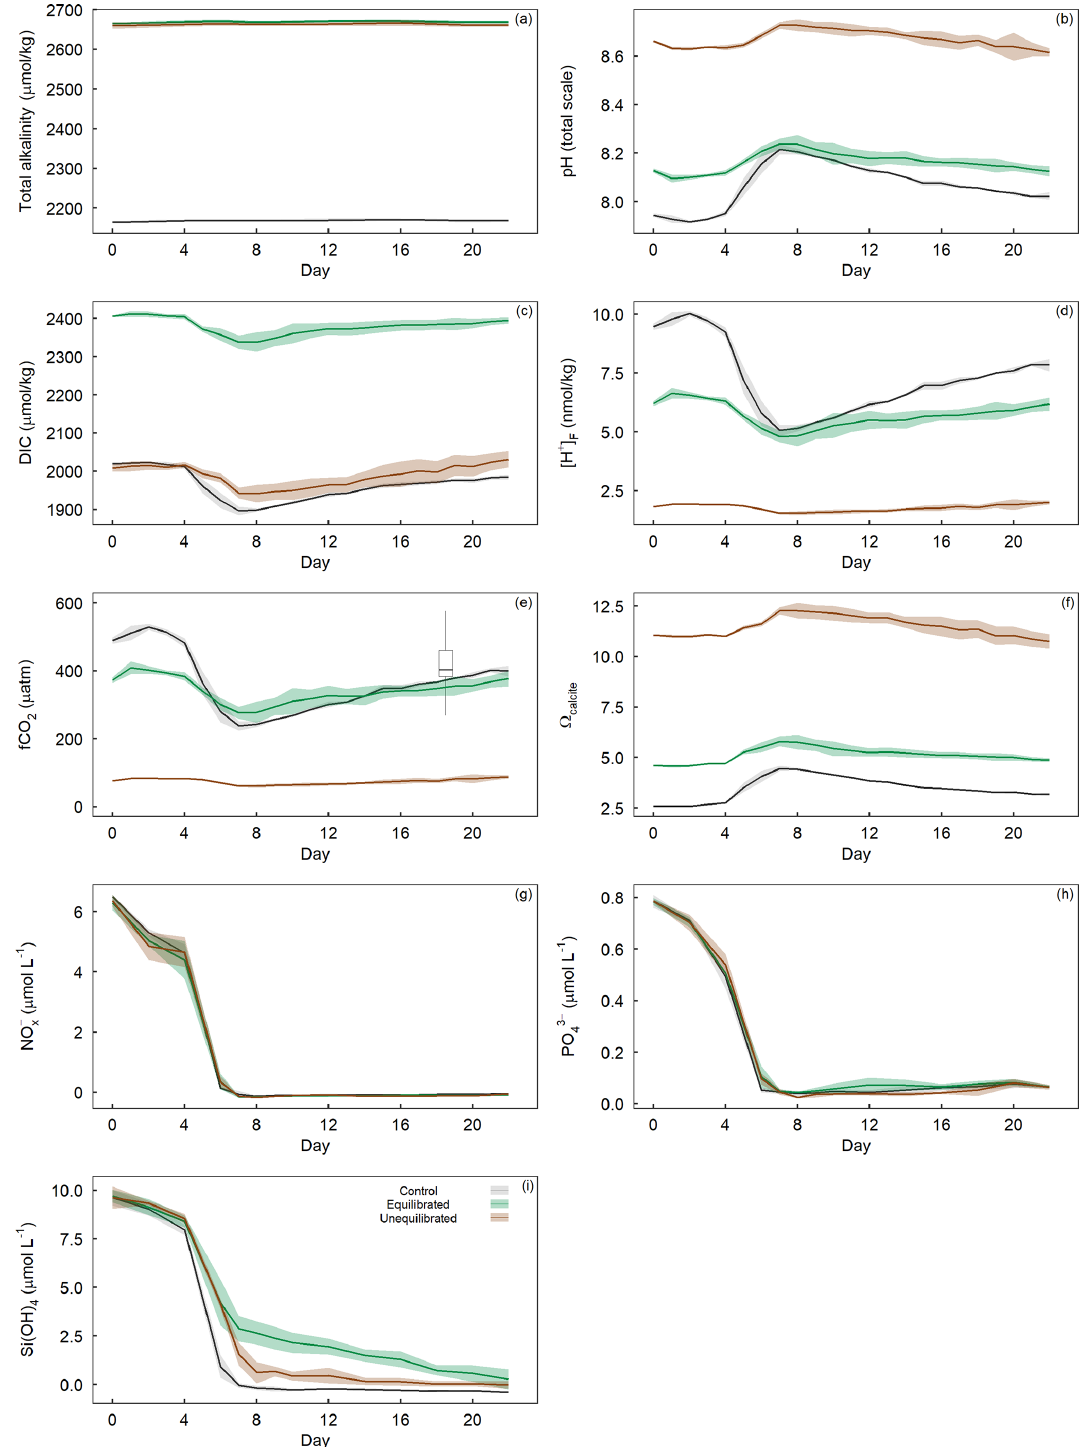
Figure 4. Temporal variation in measured (a) total alkalinity, (b) pH T , and calculated (c) dissolved inorganic carbon, (d) proton concentration on the free scale ([H + ] F ), (e) f CO 2 with overlaid boxplot illustrating the range of f CO 2 observed in the Derwent/Storm Bay area, Tasmania (42.84–43.10 ◦ S, 147.46–147.31 ◦ E), based on 10857 measurements between 1993–2019 (Bakker et al., 2016), (f) (cid:127) calcite , as well as dis- solved inorganic (g) nitrate + nitrite concentrations, (h) phosphate concentration, and (i) silicate concentration within the treatment groups. Coloured shading around the respective means represents standard deviation within a treatment